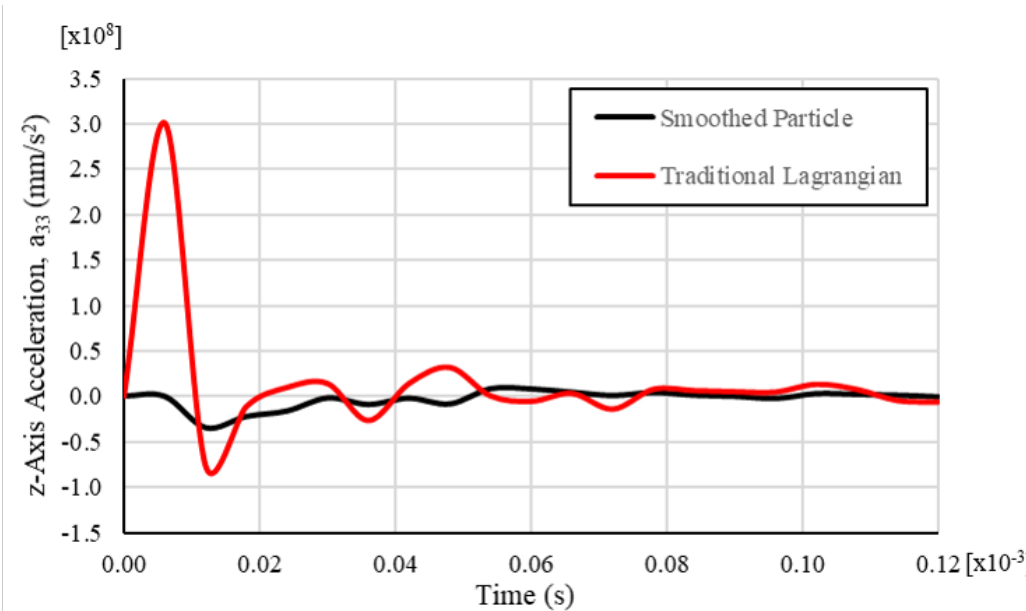
Figure 13. Comparison of Impact-Axis Acceleration between Traditional Lagrangian Finite Element and Smoothed Particle Hydrodynamics Models.